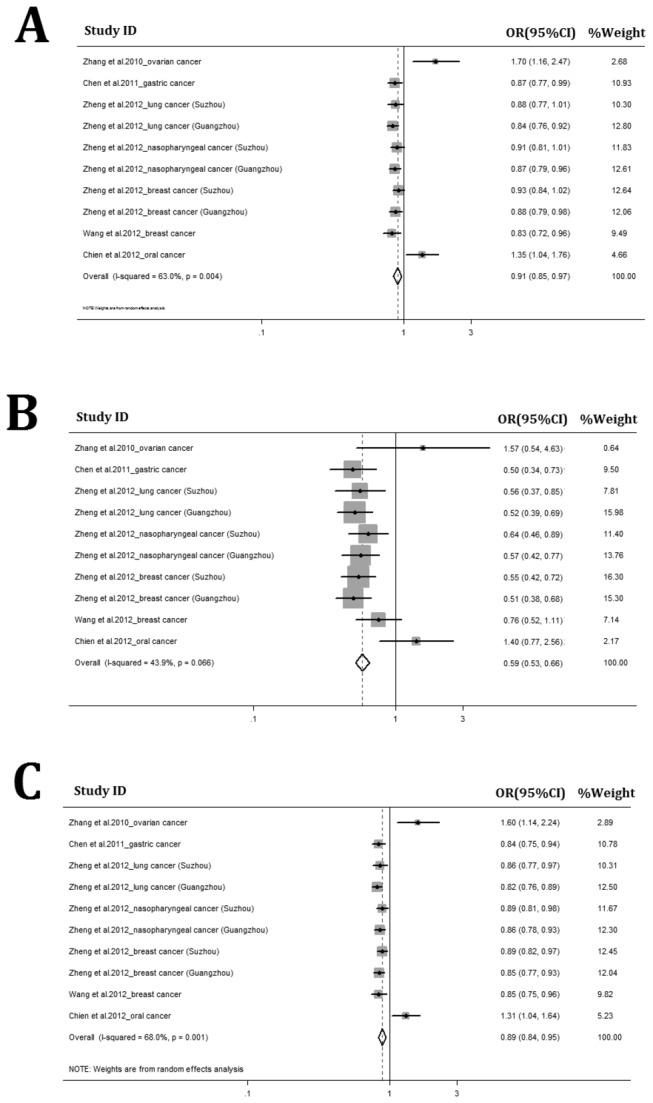
Meta-analyses for functional IL-23R rs10889677 polymorphism in multiple solid tumors.Forest plots for AC vs. AA comparison (A, CC vs. AA comparison (B), and AC + CC vs. AA comparison (C).